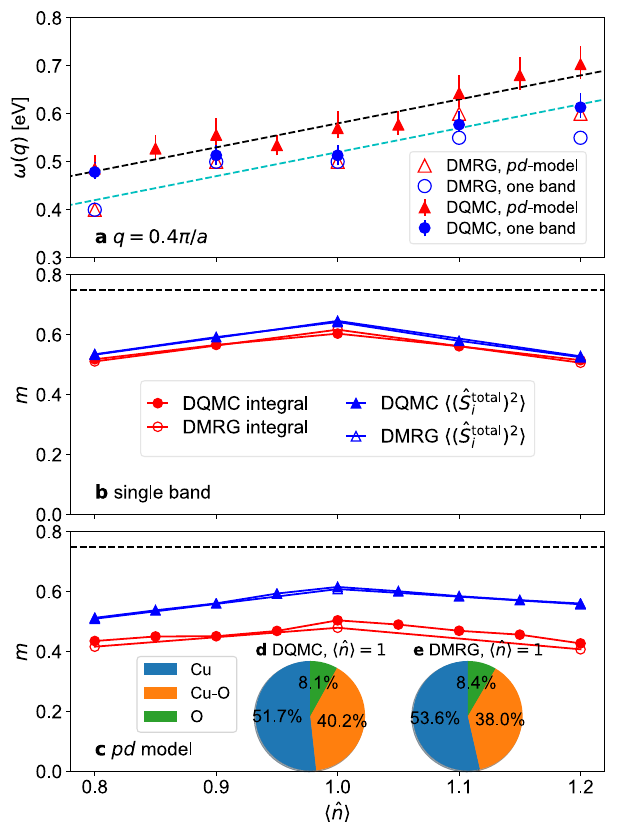
Fig. 6 The evolution of the magnetic moment and excitations with doping h ^ n i . a The shift in energy ω ( q ) of the maximum of S ( q = 0.4 π / a , ω ) as a function of doping in the multi-orbital Cu − O pd - and single-band models. The dashed lines are guides to the eye. Panels b , c show the evolution of the magnetic moment in the single-band (panel b ) and pd -models (panel c ). The blue triangles indicate the value of m estimated by computing the 2 i expectation value of the local spin operator hð ^ S total i Þ while the red circles indicate the value of m estimated by integrating S ( q , ω ) from ω ∈ [0, 3] eV. Results are shown for determinant quantum Monte Carlo (DQMC) simulations at T = 0.0625 eV and density matrix renormalization group (DMRG) simulations at zero temperature. The pie charts insets show the weight of the Cu, O, and Cu − O components of the moment calculated using d DQMC and e DMRG (see “ Methods ”